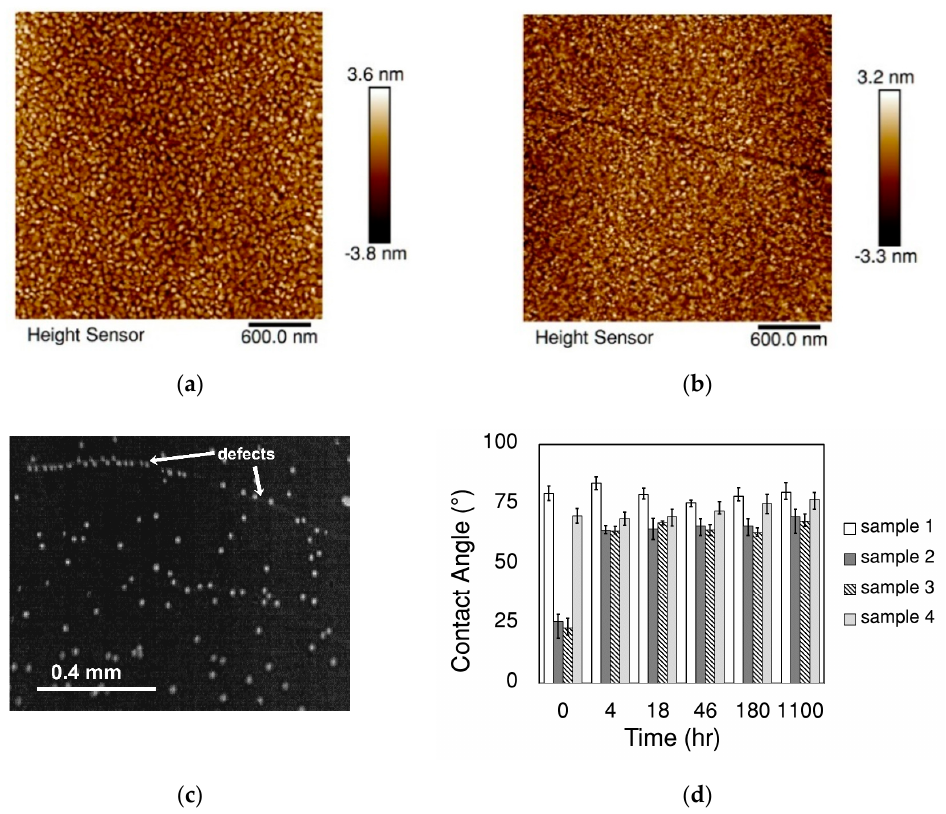
Figure 2. AFM images of the sample 2 surface (gold-coated glass, plasma-cleaned and stored in an open container at room conditions) after exposure times of ( a ) 2 h and ( b ) 185 h. ( c ) SPRi of dropwise condensation (the darker color represents the gold substrate and the brighter color shows the droplets) shows surface defects can cause heterogeneous nucleation. ( d ) Contact angle measurements of the